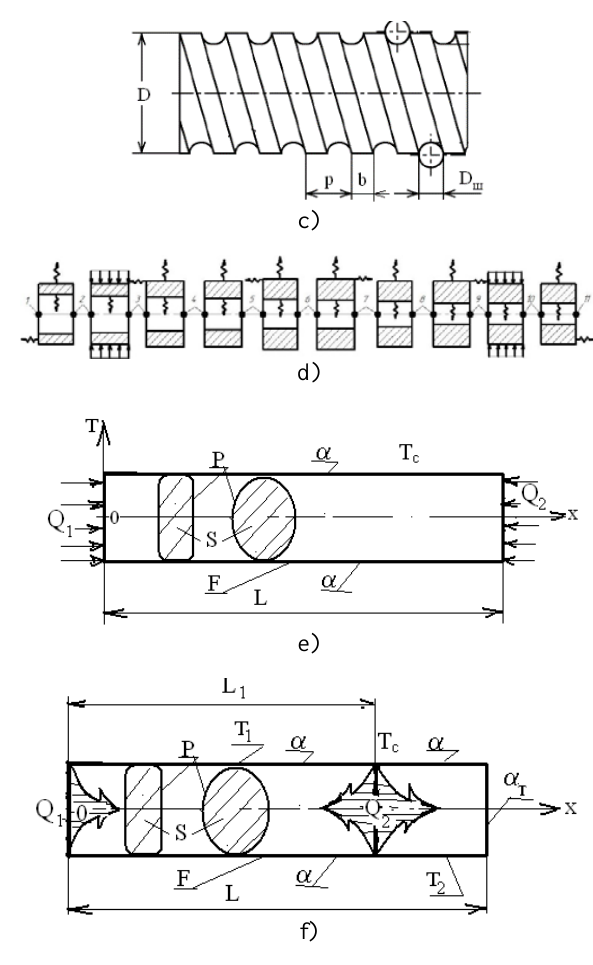
Fig. 2. Thermal image of the spindle – a, b; parameters of the ball screw-c; thermal models for FEM-d; reduced to the cylinder-d,